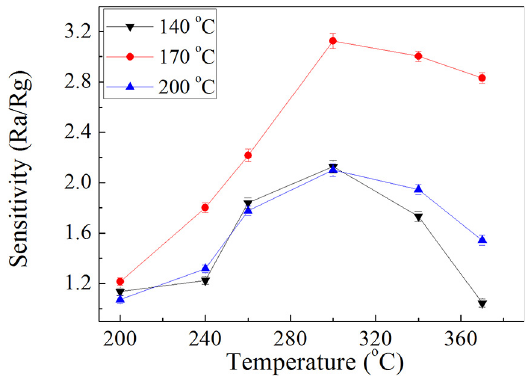
MoO sensor at different operating 2 6